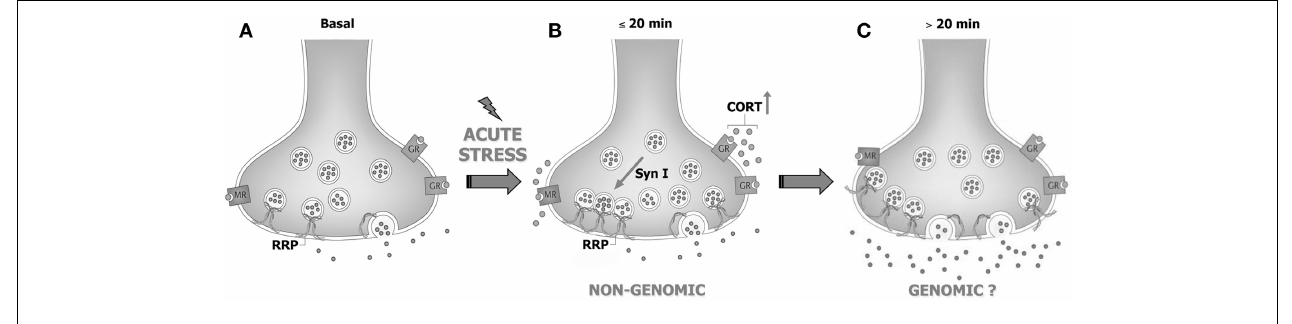
RRP. This requires binding of corticosterone to synaptic MR/GR and non-genomic mechanisms involving phosphorylation of the presynaptic protein synapsin I. The increase of RRP size non-genomically induced by corticosterone primes the terminal but is not sufficient for the enhancement of glutamate release and transmission induced by acute stress. (C) We speculate that slower ( > 20min), likely genomic effects are required to promote the enhancement of glutamate release and transmission induced by acute stress. See text for details. Adapted from Treccani et al. (86).